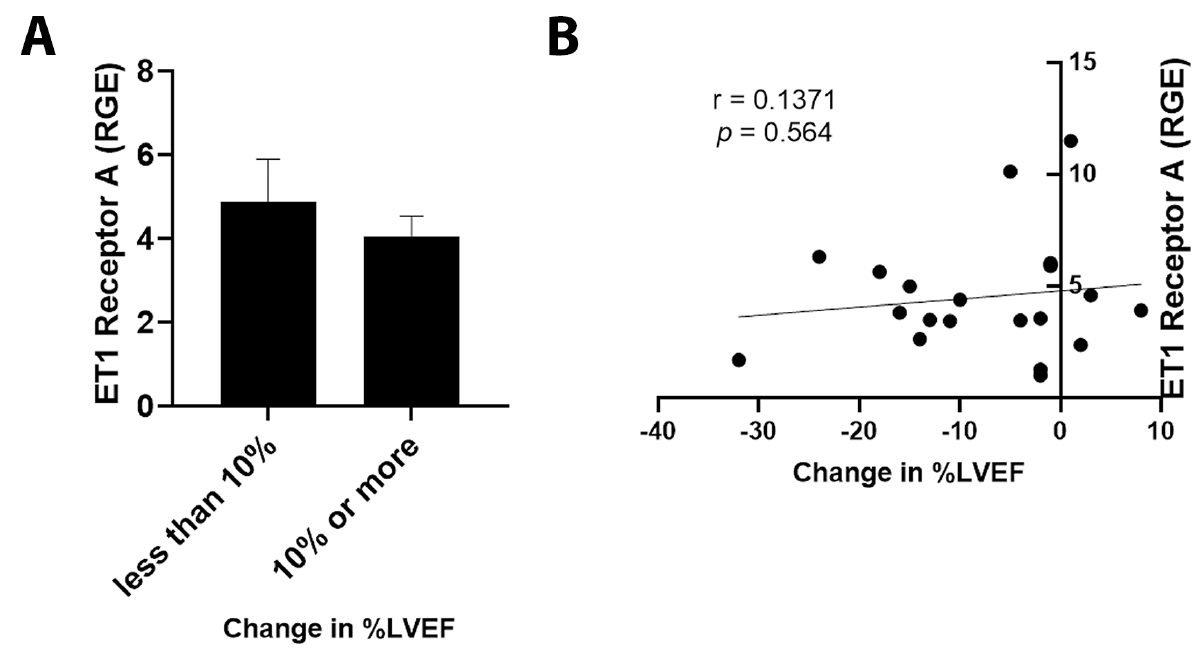
Figure 6. Relationship between change in percentage of LVEF <10% or ≥10% and ET1 Receptor A. ( A ) Relative gene expression (RGE) of ET1 receptor A by qRT-PCR ( p = 0.248) compared to the housekeeping gene PUM1. ( B ) Pearson correlation for ET1 Receptor A expression vs. change in percentage of LVEF ( p = 0.564). n = 20.